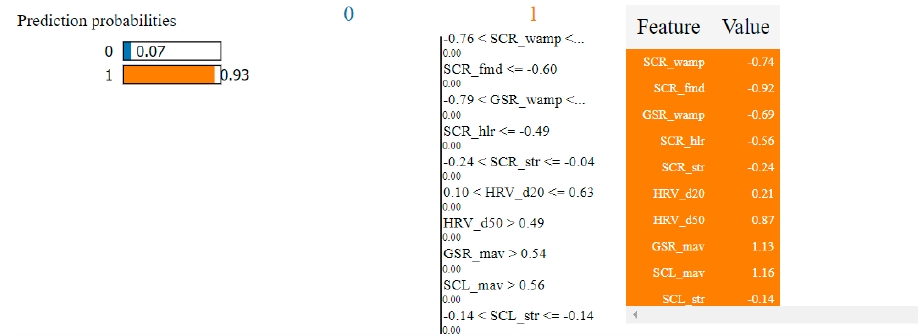
Figure 28. Prediction features for situation 1 (fear), for the overlapping dataset.